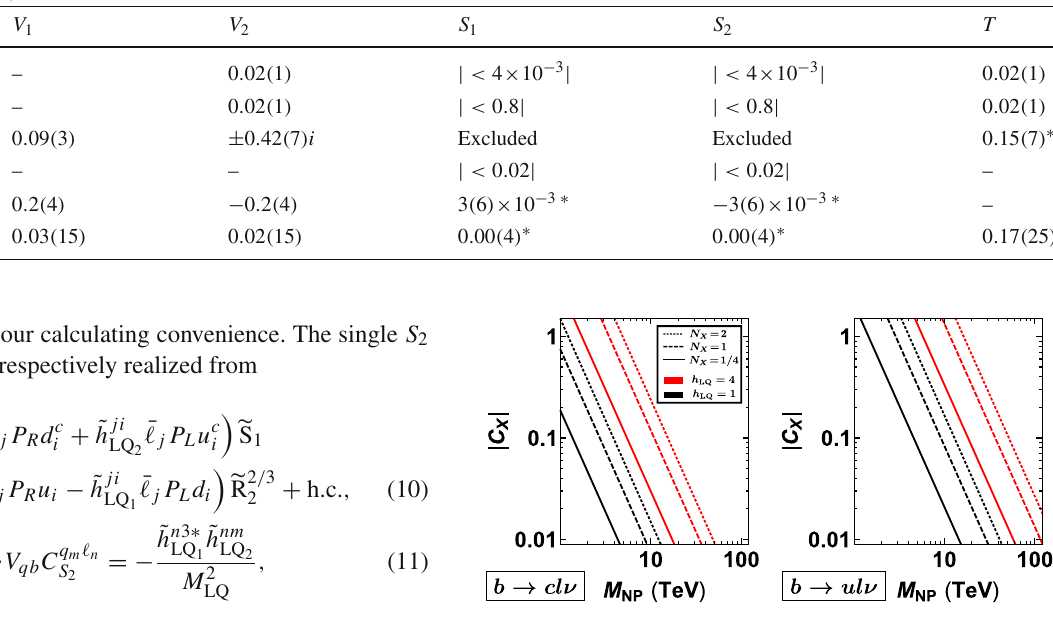
results with ∗ indicate that there exist another best fit point outside of C X ∼ 0. The C c τ result ( ∗∗ ) is given real part by fixing the imaginary T = ± 0 . 19. See the main text for these details part to be Im C c τ T